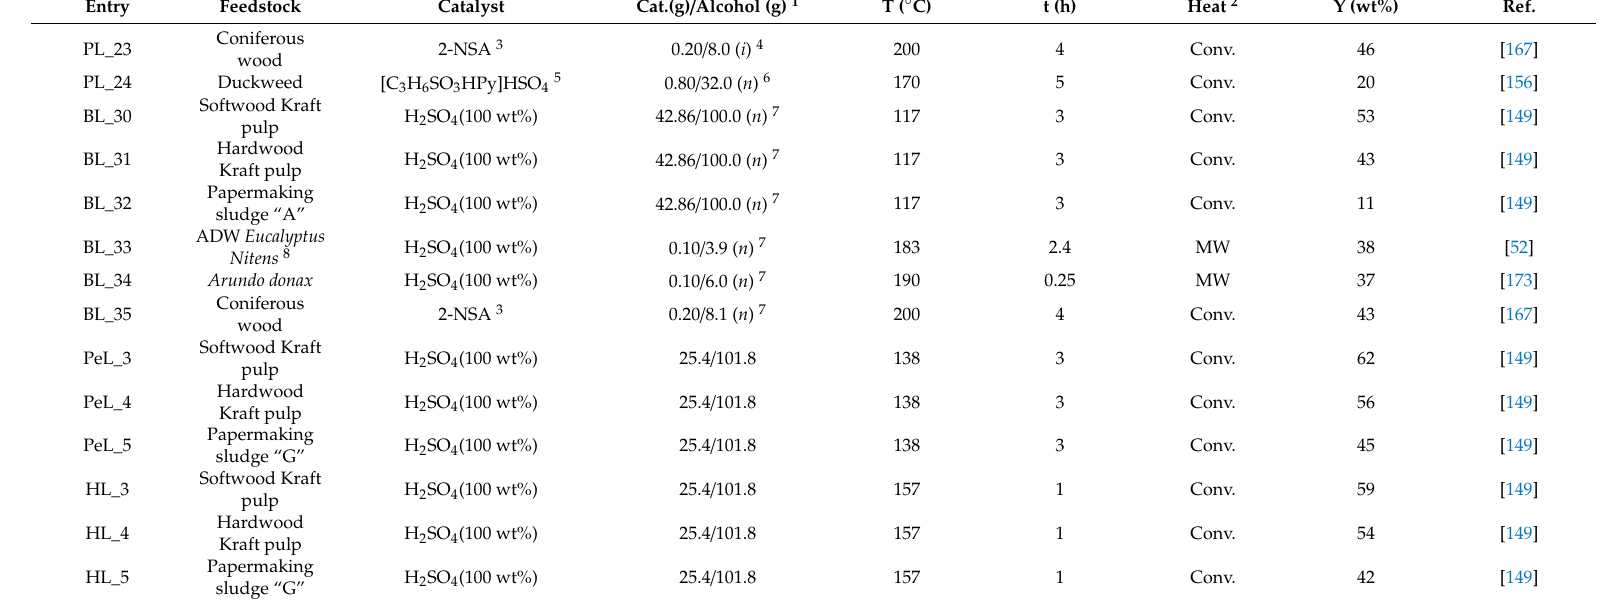
Table 17. Catalysts for the PL, BL, PeL, and HL production from real